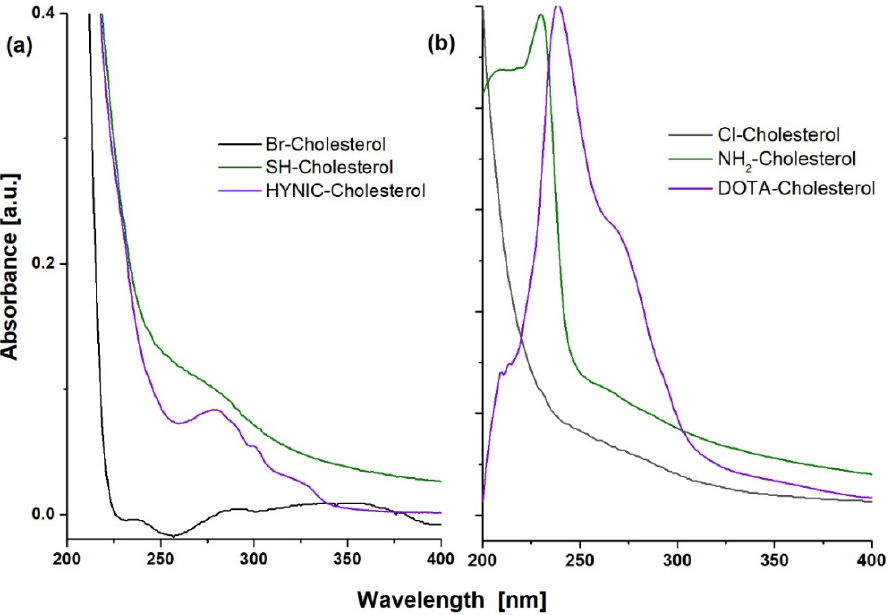
Figure 2. UV-Vis spectra of ( a ) HYNIC-S-(CH 2 ) 3 -S-Cholesterol (HYNIC-Cholesterol) and its Br- and SH- precursors and ( b ) DOTA-benzene- p -SC-NH-(CH 2 ) 3 -NH-Cholesterol (DOTA-Cholesterol) and its Cl- and NH 2 - precursors.